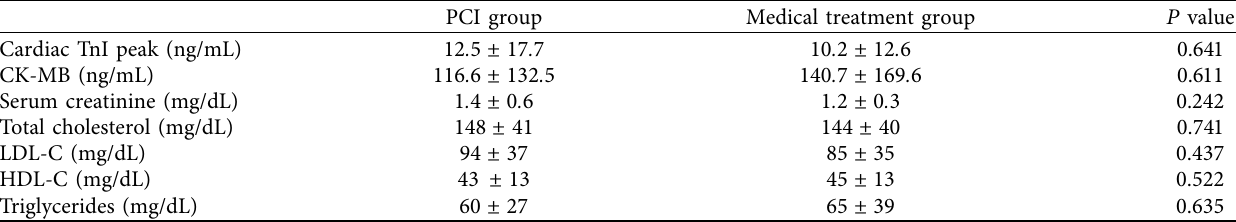
Table 2: Biological parameters.